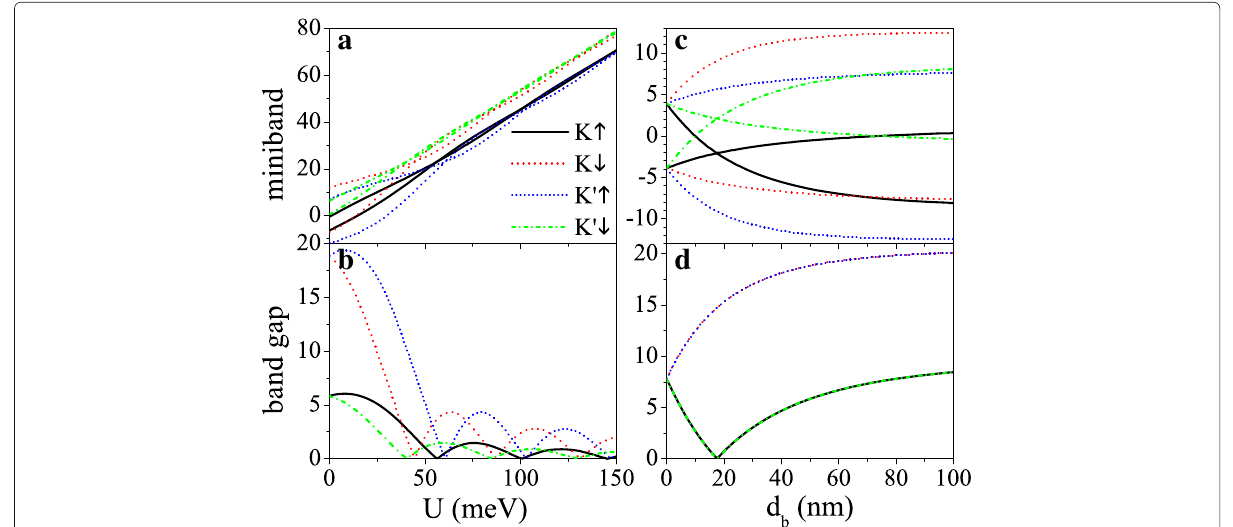
Fig. 4 ( a ) Minibands near Fermi level and ( b ) their band gaps at original Dirac point versus potential U , at d b = d w = 50 nm. ( c ) Minibands near Fermi level and ( d ) their band gaps at original Dirac point versus d b , at U = 0 and d w = 50 nm. The values of other parameters are h = 8.0 meV, = 15.0 meV, and k = k = (cid:2) z x y